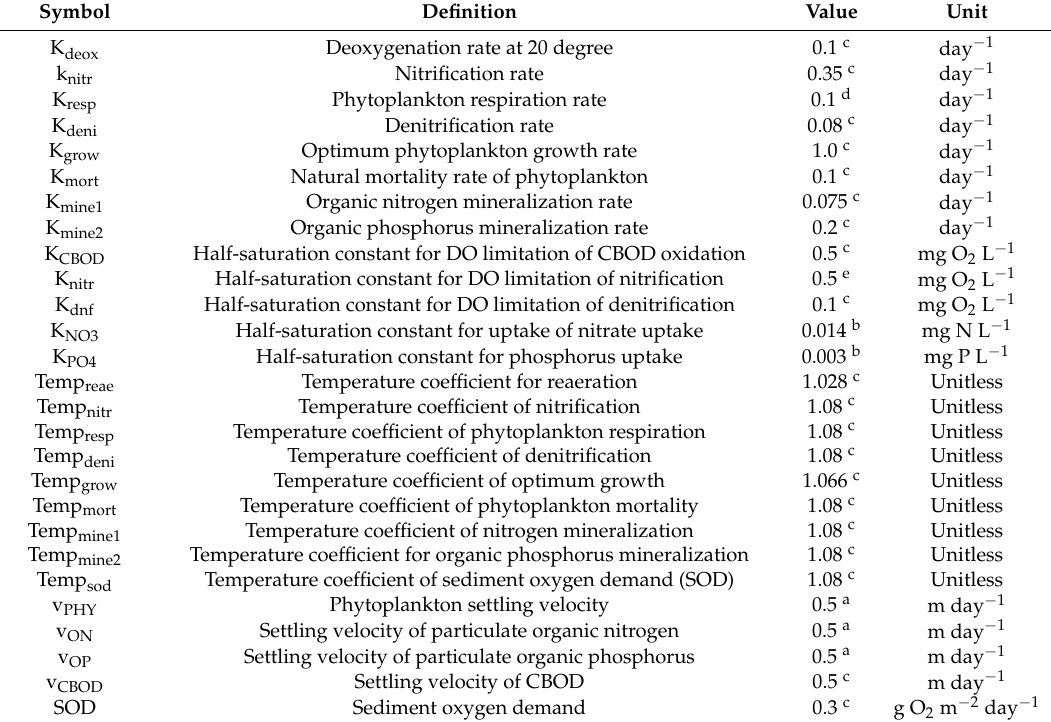
Table 2. Parameter values used in the WASP water quality